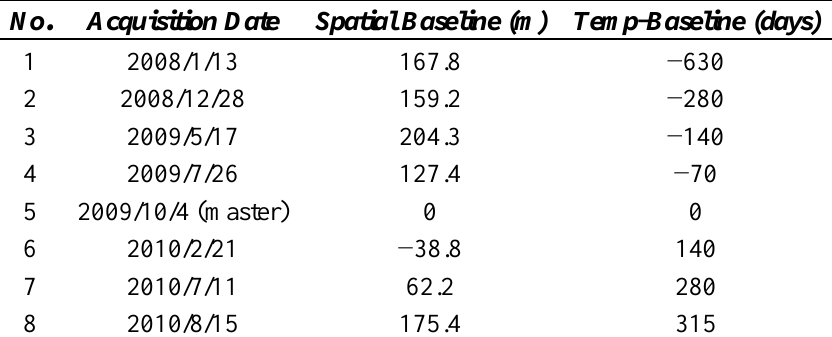
Table 4. Specifications of ENVISAT data used.